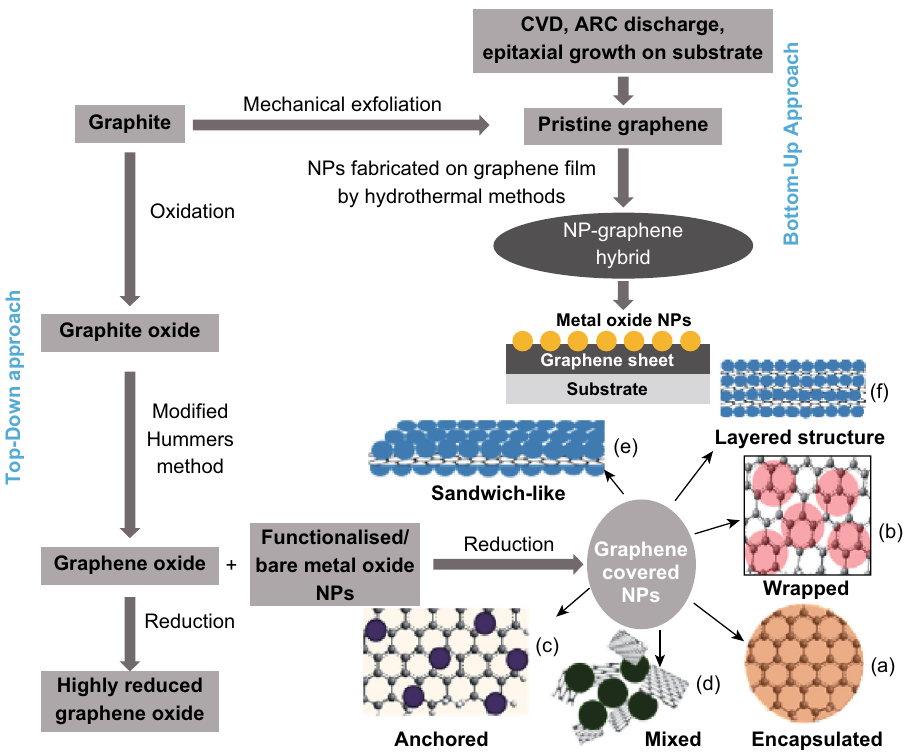
Fig. 4 Schematic presentation of graphene synthesis methods—‘top-down’ and ‘bottom-up’—used for the formation of GBN hybrids and different structures. a Graphene-encapsulated NPs. b Graphene-wrapped NPs. c NPs anchored to graphene structures. d Mixed graphene-NP structures. e Graphene-NP sandwich structures. f Graphene-NP layered hybrids [30]. Copyright (cid:2) 2017 Jana et al.; licensee